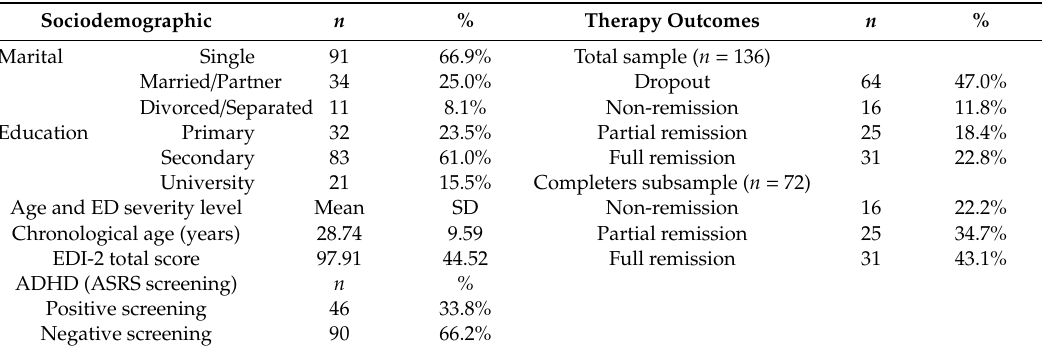
Table 1. Descriptive for the sample ( n =